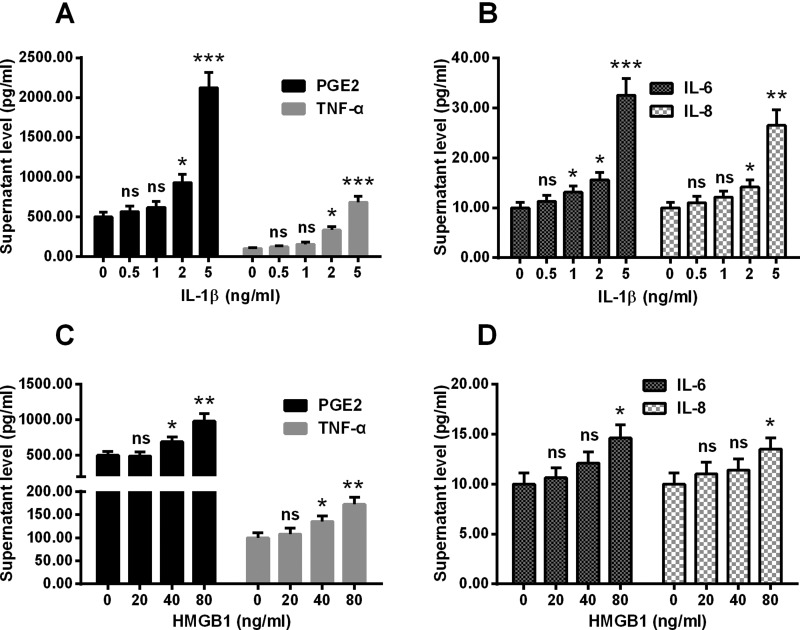
Supernatant levels of PGE2, TNF-α, IL-6 and IL-8 in the disc annulus fibrosus cells which were treated with IL-1β or HMGB1Disc annulus fibrosus cells were treated with 0, 0.5, 1, 2 or 5 ng/ml IL-1β or with 0, 20, 40 or 80 ng/ml HMGB1 for 24 h, then the supernatant levels of PGE2, TNF-α, IL-6 and IL-8 were examined with ELISA methods. (A and B) Supernatant levels of PGE2 and TNF-α (A) or IL-6 and IL-8 (B) in the IL-1β-treated disc annulus fibrosus cells. (C and D): Supernatant levels of PGE2 and TNF-α (C) or IL-6 and IL-8 (D) in the HMGB1-treated disc annulus fibrosus cells. Results are presented as mean ± S.E.M. for quartic independent experiments. P values were calculated by Student t test between two groups, post the ANOVA test for the homogeneity of variance. *P<0.05, **P<0.01, ***P<0.001 or ns: no significance.